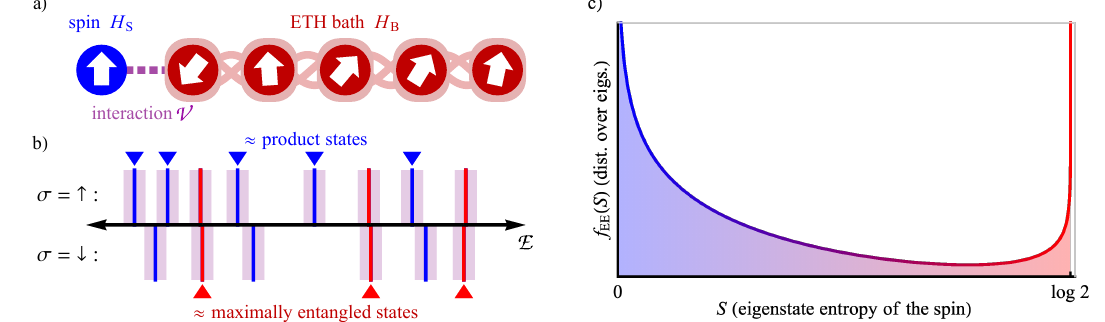
Figure 1: a) Model : a spin- 1 intermediately coupled to a many-body quantum bath. 2 b) A window of the spectrum : Energy levels in the two spin sectors σ = ↑ / ↓ of the de- coupled Hamiltonian are denoted above / below the energy axis. Two levels strongly hybridise if their energy separation is much smaller than the typical matrix element connecting them (purple collar). Typical levels (blue) do not hybridise, while rare pairs strongly hybridise and form cat states (red). c) Distribution of spin eigenstate entanglement entropies f : f is bi-modal with a mode at S = 0 ( S = log2) due to EE EE the blue (red) states in